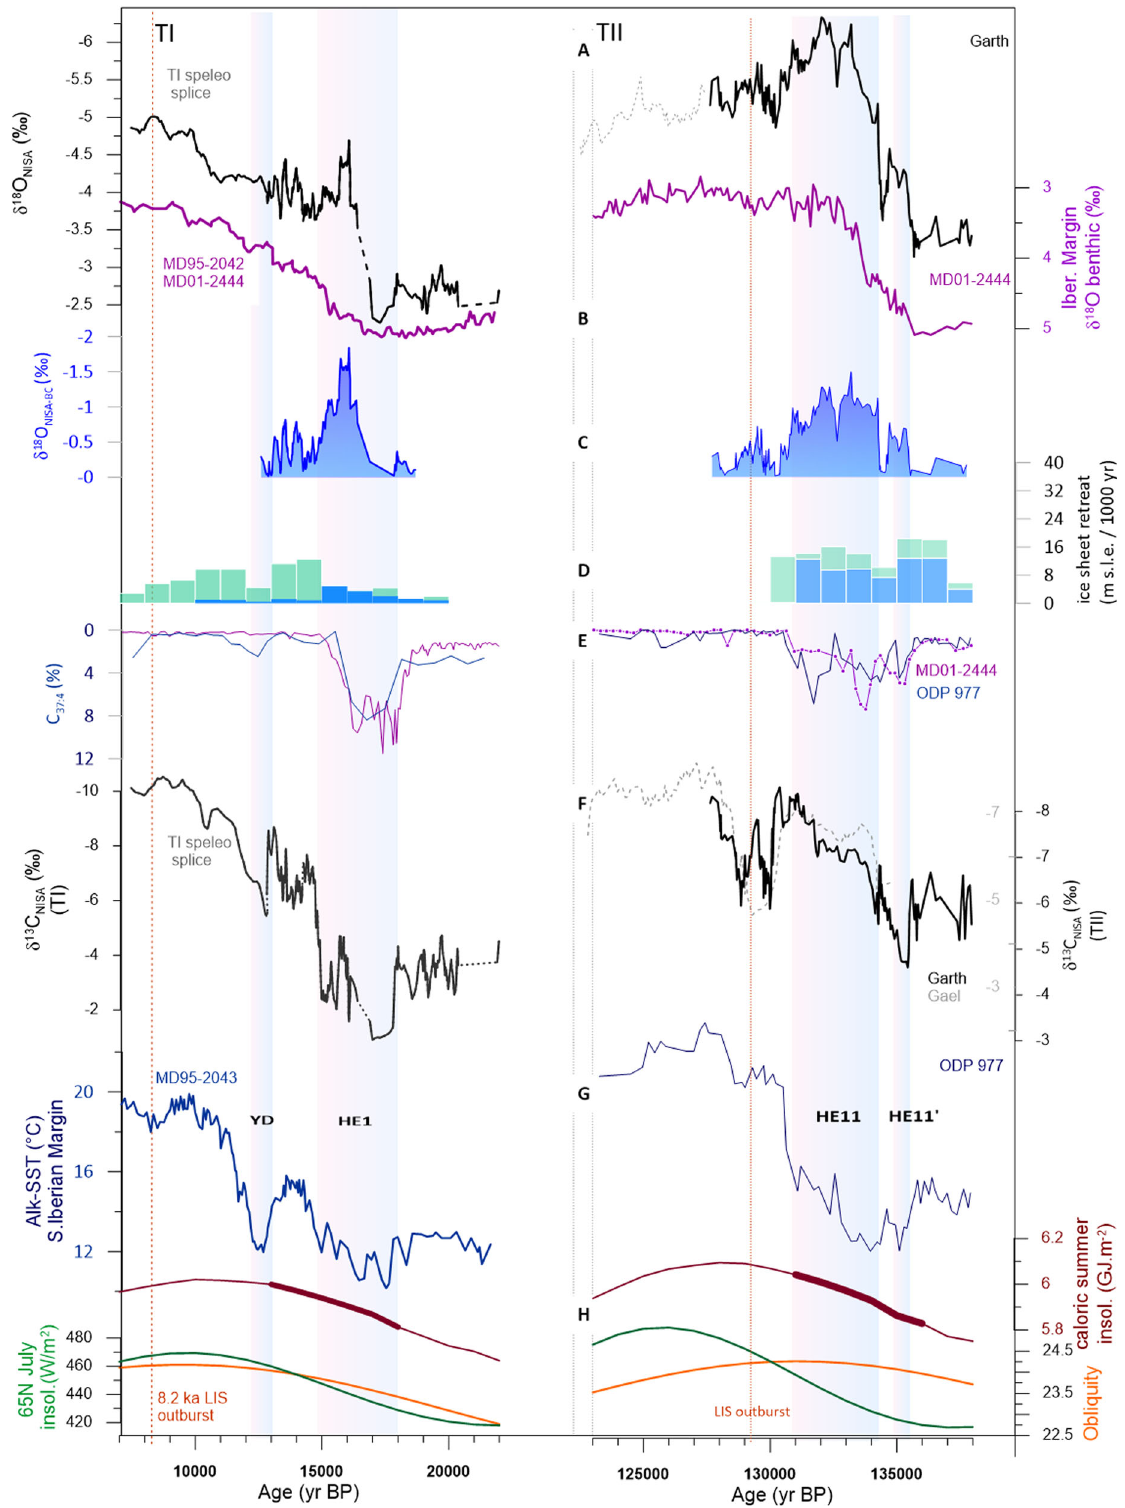
images were obtained under 100 – 200x magni fi cation using an incident wavelength of 488nm and measuring fl uorescence in a 490 – 590 nm window. Images were obtained at 1024 × 1024 or 2048 × 2048 resolution, corresponding to 1.2 to 0.6µm/ pixel (respectively) under 100x magni fi cation. Images were processed using Fiji/ ImageJ, where the exact distances between growth layers were recorded on an absolute length scale and later cross-referenced to laser ablation and drilling (isotope, trace element) data. Confocal images were counted in stalagmite Garth section from 177.5 to 269.5 mm from the tip. Growth layer thickness was used